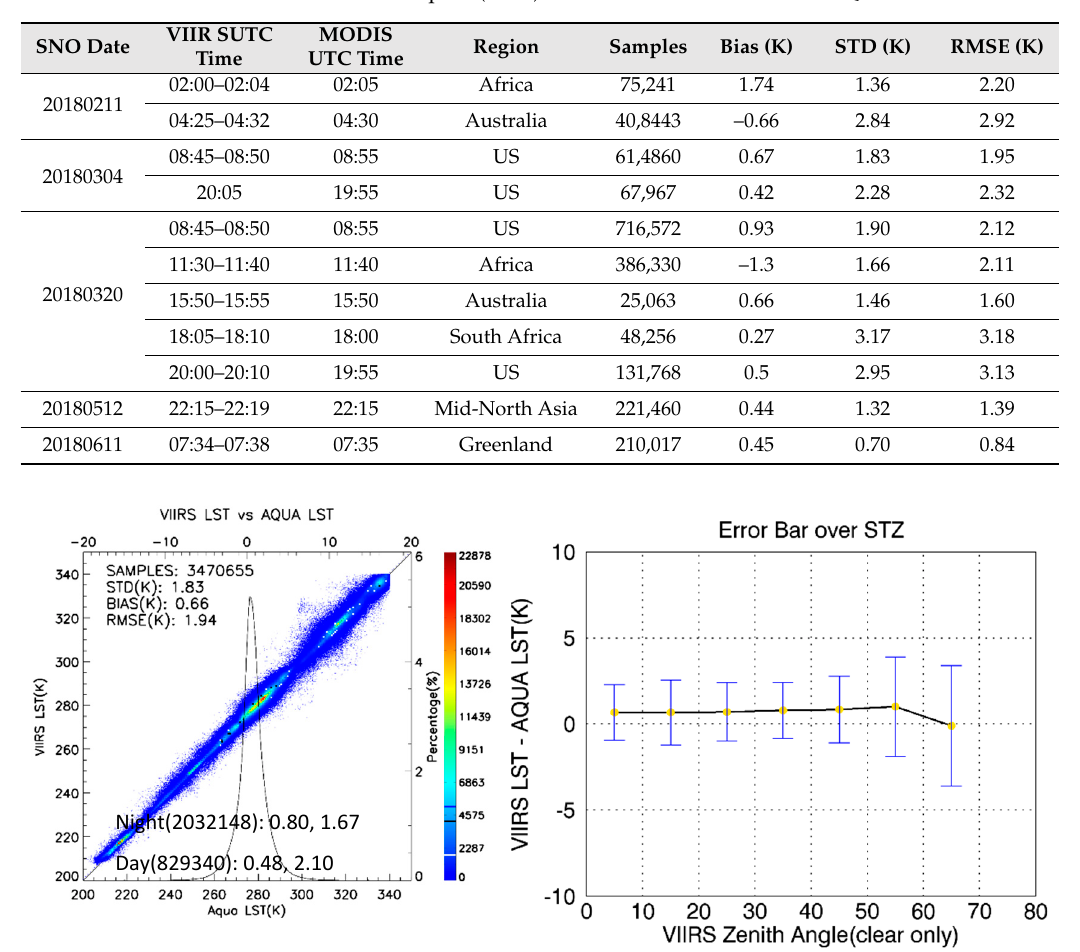
Table 8. Simultaneous nadir overpass (SNO) list between N20 VIIRS and AQUA MODIS.